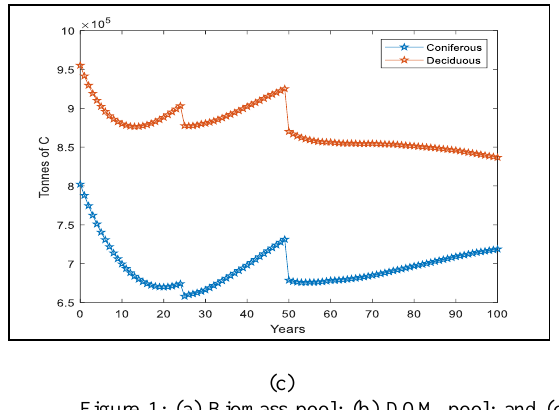
Figure 1: (a) Biomass pool; (b) DOM pool; and (c) Total Ecosystem carbon pool for a two-stand